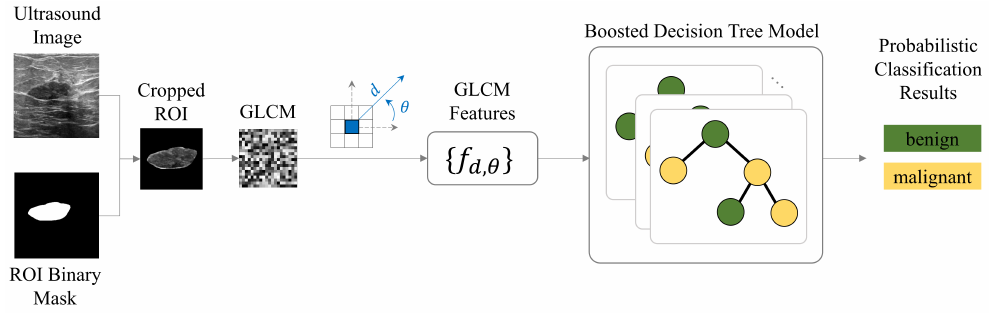
Figure 1. Our proposed pipeline uses the ultrasound image and ROI mask to extract GLCM texture features and learns a boosted decision tree model to make probabilistic diagnosis based on explainable decision trees.